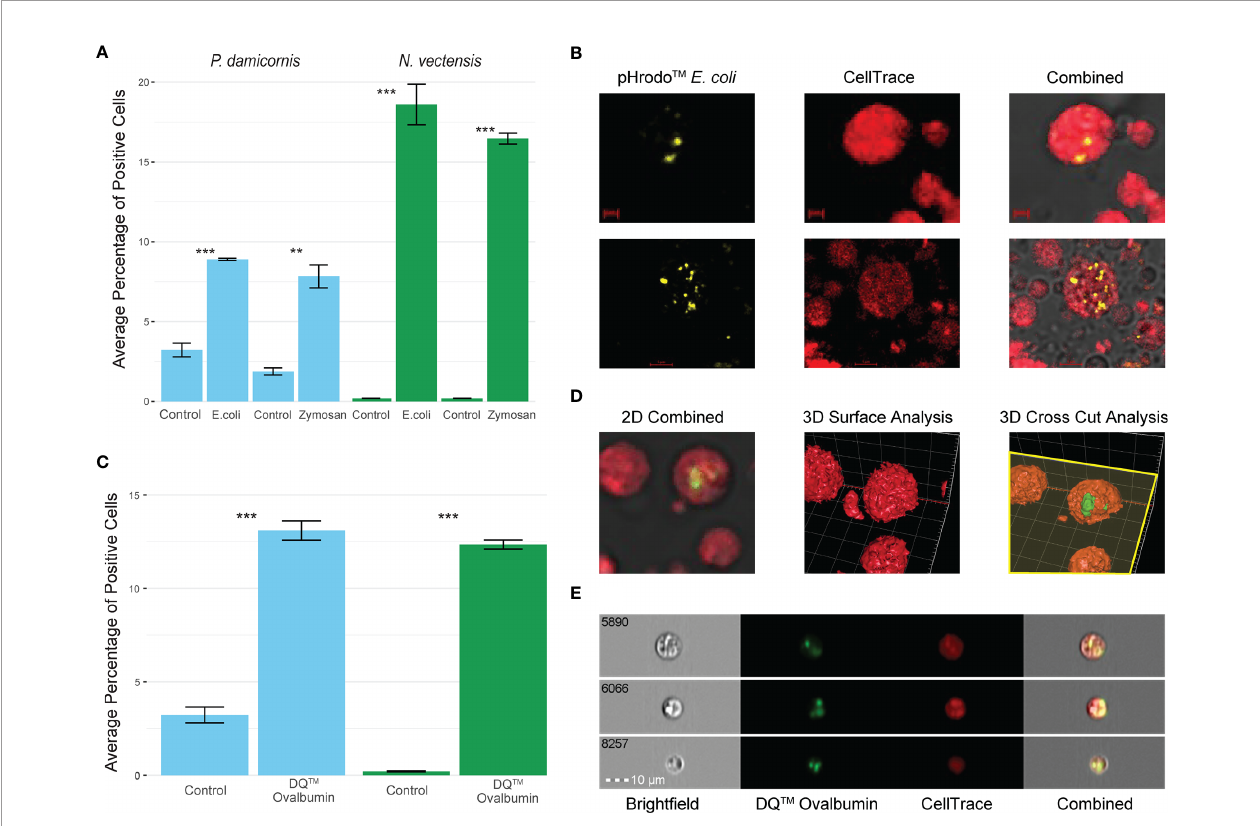
FIGURE 2 | Phagocytosis in P. damicornis and N. vectensis of different antigens, and their fusion with low pH vesicles and protein degradation. (A) Percentage of cells in P. damicornis (blue bars) and N. vectensis (green bars) that engulfed pHrodo ™ E. coli (left) and pHrodo ™ zymosan (right) particles. Each test treatment is signi fi cantly different from the respective control treatment. (B) Images of isolated N. vectensis cells challenged with pHrodo-red ™ E. coli particles, taken by confocal microscopy. Left: internalized, pH-activated E. coli particles that fl uoresce brightly in acidic environments. Middle: N. vectensis stained with CellTrace. Right: Overlays of left and middle panels in confocal microscopy PMT. E. coli particles fl uoresce after the fusion with low pH lysolitic vesicles. Scale bar for upper panels 2 m m, and 5 m m for lower panels. (C) Percentage of cells in P. damicornis (blue bars) and N. vectensis (green bars) that engulfed DQ ™ ovalbumin, a particle that only fl uoresces bright green when hydrolysis by proteases due to the quenching of the reagent. The number of cells engul fi ng the ovalbumin is signi fi cantly higher than that of the control treatment. (D) 3D analysis of a N. vectensis cell stained with CellTrace and has been exposed to DQ ™ ovalbumin. Left: 2D overlay of confocal microscopy and PMT, bar-2 m m. Middle: 3D surface analysis of the same N. vectensis cell featured in the left panel and shows the absence of DQ ™ ovalbumin from the surface of the cell. Right: 3D cross-sectional analysis of the same N. vectensis cell featured in the left and middle panels and shows fl uorescing DQ ™ ovalbumin particles within the cell. The yellow plane depicts the cross section done in the Z-axis (right panel), and surface analysis of the parts below the plane to show what is inside the cells. Grid scales are 3 m m. (E) Inserts of ImageStream analysis of N. vectensis cell stained with CellTrace (red) and has been exposed to DQ ™ ovalbumin (green upon protein hydrolysis), scale bar 10 m m. P-value marks: **p < 0.01, ***p <